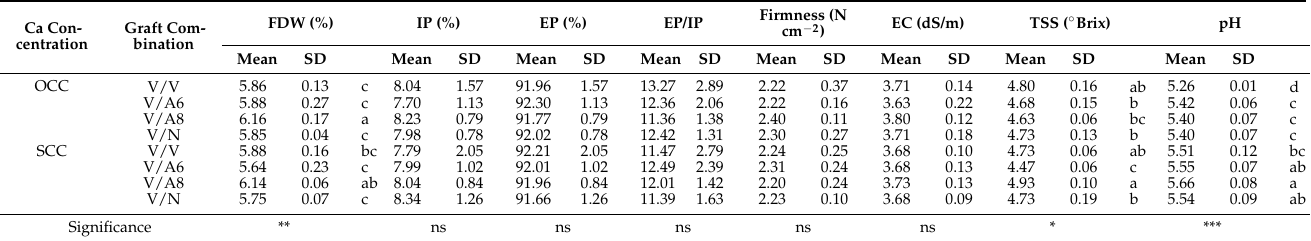
Table 5. Effects of calcium concentration and plant combinations ondry weight (FDW), percentage of inedible (IP) and edible (EP) part, ratio between edible and inedible parts (EP/IP), firmness, total soluble solids (TSS) and pH of pepper fruits at 84